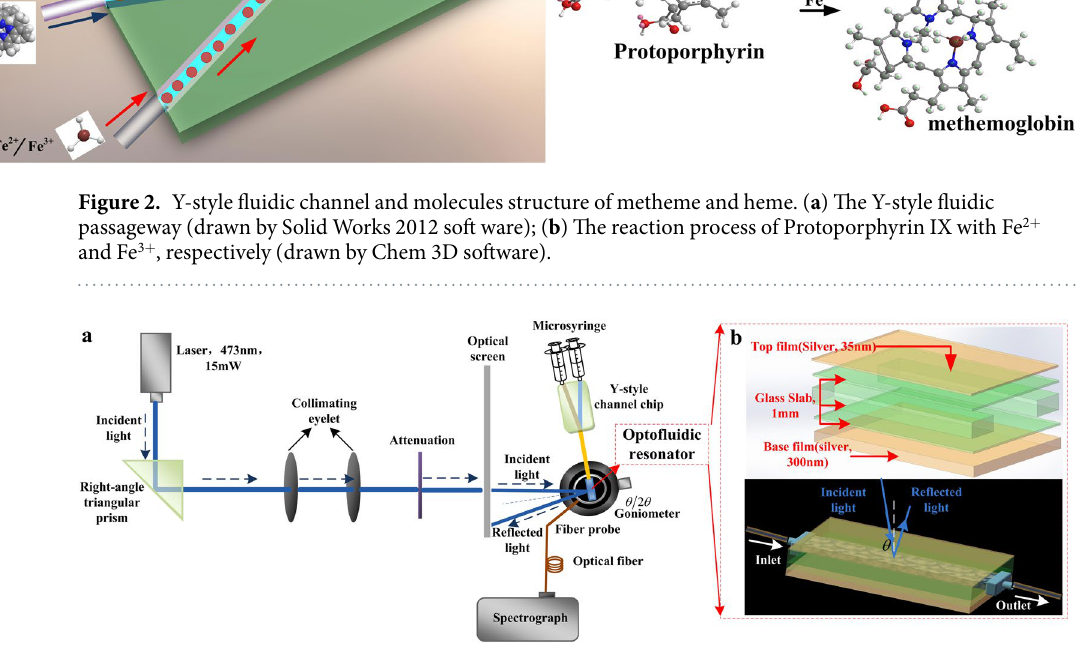
Figure 3. Experimental system and the optofluidic resonator. ( a ) The schematic image of the experimental setup (drawn by 3ds Max 2013 soft ware); ( b ) Structure of optofluidic resonator and the coupling light path (drawn by Solid Works 2012 soft